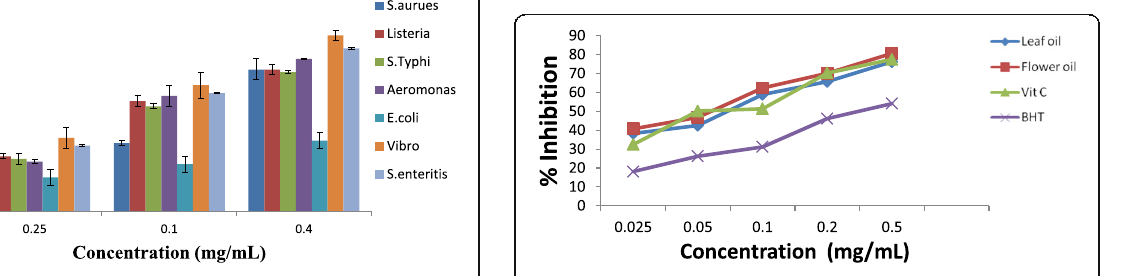
Fig. 3 DPPH scavenging action Fig. 1 Antibacterial activity of leaves oil of Callistemon